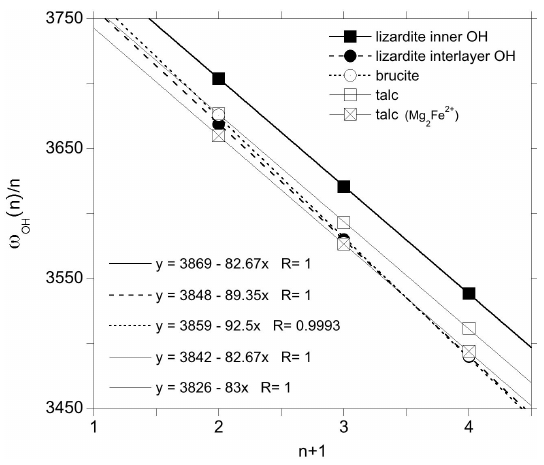
Figure 6. Fundamental and overtone frequencies as a function of the quantum number n characterizing the excited state. The lin- ear regressions correspond to the application of the 1-D relation (Eq. 1). The squares and circles correspond to inner and interlayer OH groups,